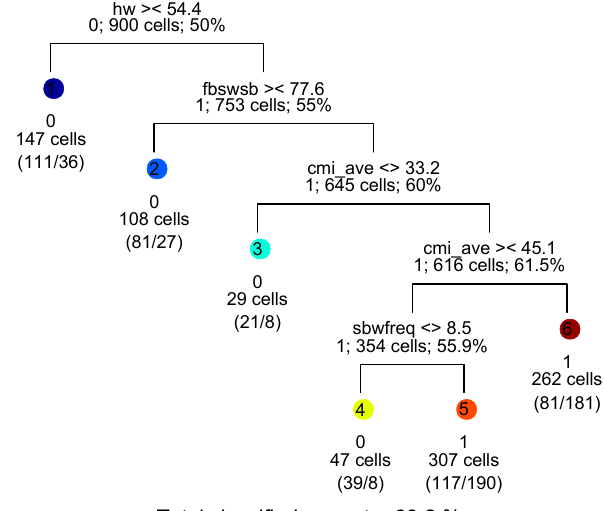
Figure 3. Classification tree of the presence (1) or absence (0) of ‘likely interaction’ between large fires and spruce budworm defoliation in Ontario’s spruce budworm belt (Figure 1A) from 1941 to 2005. Five splits (horizontal bars) and six leaves (circles numbered 1–6 from left to right) are shown. A variable is shown above each bar followed by the two inequality signs, ‘>’ and ‘<’. The inequality sign on the left (right) applies to the left (right) end of the bar. The variables are the number of years of moderate–severe defoliation (sbwfreq), the average climate moisture index (cmi_ave), the percentage of the total basal area that is hardwood (hw) or balsam fir, white spruce and black spruce combined (fbswsb). The ‘0’ or ‘1’ directly below the circle at each leaf and leading the second line above each bar indicate whether the previous split classified this group of cells as having conditions conducive to the presence (1) or absence (0) of interaction. The ‘0’ or ‘1’ is followed by the group size (# cells) and then, for the bars, the correct classification %, and for leaves, parentheses enclosing the numbers of cells where absence/presence [of a “likely interaction”] is predicted. See text for further explanation.